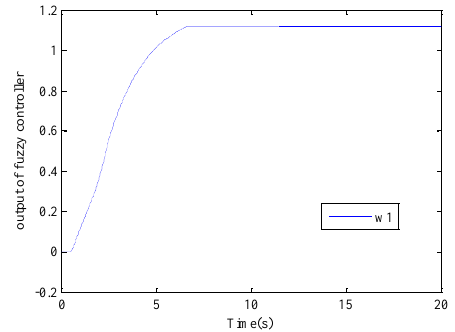
Figure 3. Output surface of the fuzzy interface